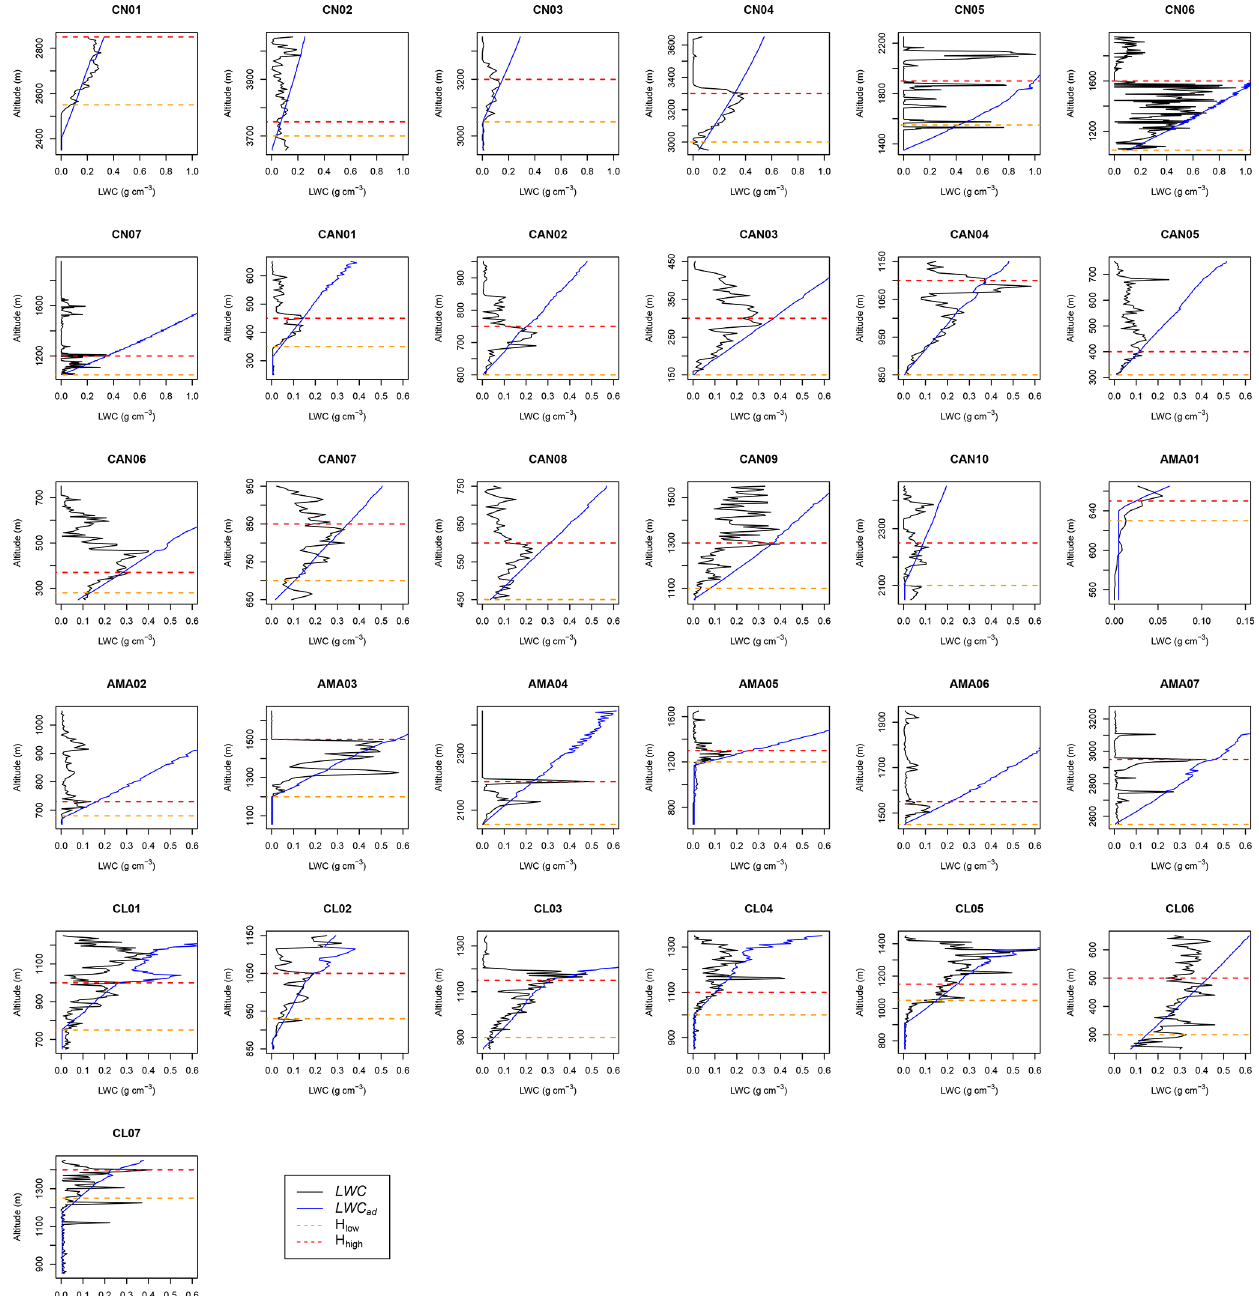
Figure B1. The profiles of observed LWC (black) and adiabatic LWC (LWC ad , blue) for 31 cloud cases.